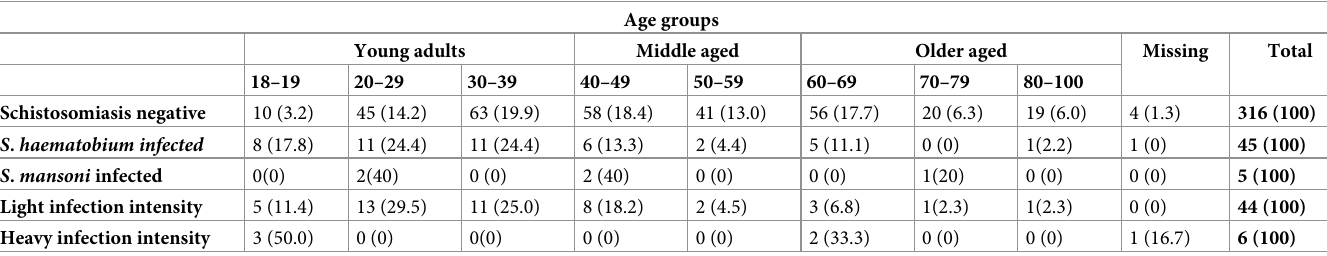
Table 1. Participant demographics by age, schistosomiasis status and infection